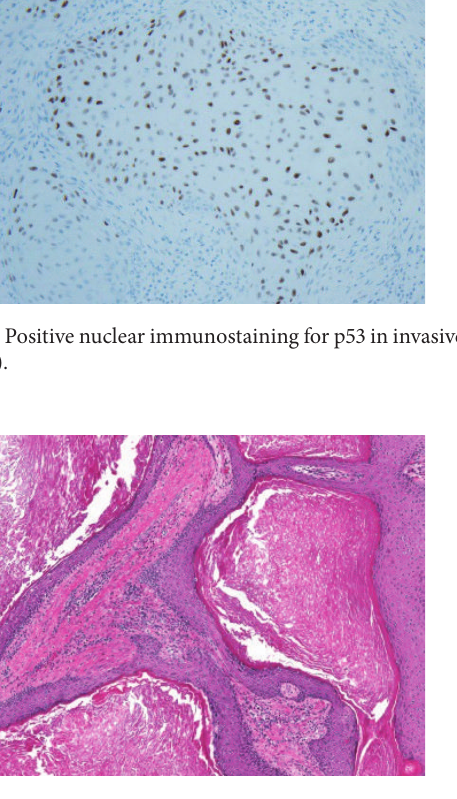
Figure 9: Superficial aspect of resected specimen (HE,